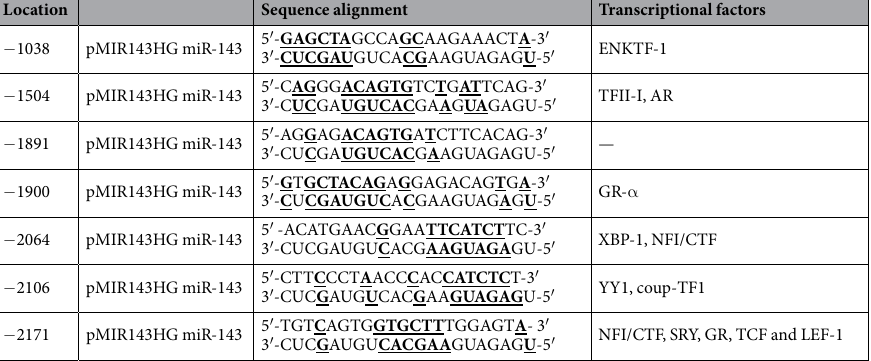
Table 2. Position and nucleotide sequences of overlapping regions between putative miR-143 target sites and transcriptional motifs on the MIR143HG promoter region. The promoter position of the nucleotide with respect to the transcription start site (defined as position 0) that is aligned to the 3 ′ end of each putative miR- 143 binding site in MIR143HG promoter region is indicated under the “Location” column. Underlined bolded letters indicate the complementary sequences for putative binding between the microRNA seed region and transcription factor motifs on the MIR143HG promoter.